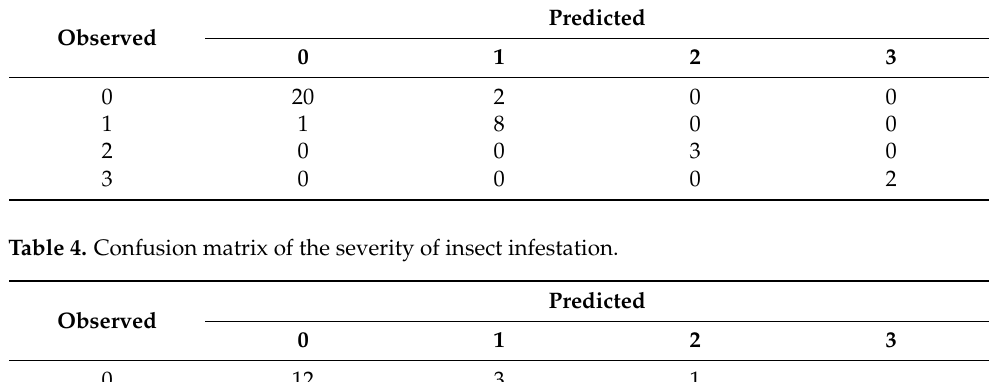
Table 3. Classification matrix.